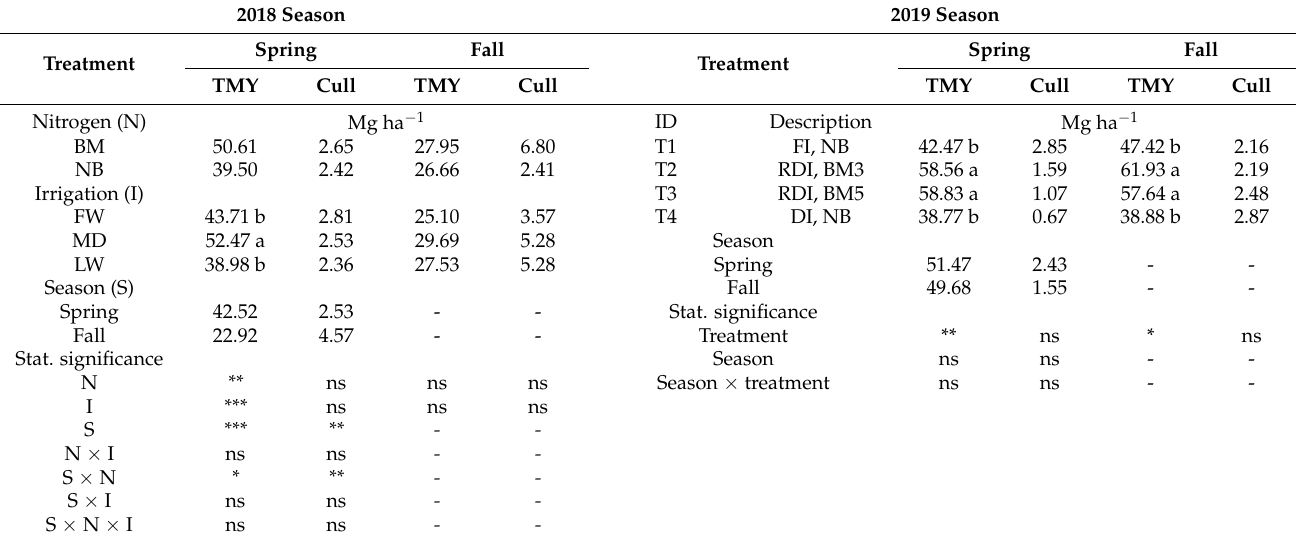
Means with different letters indicate statistical differences at α ≤ 0.05. *, **, and *** denote statistically significant difference among treatments at α value between 0.05–0.01, 0.009–0.005 and <0.005, respectively. ns = no significant difference at α ≤ 0.05. TB = total biomass production at each growth